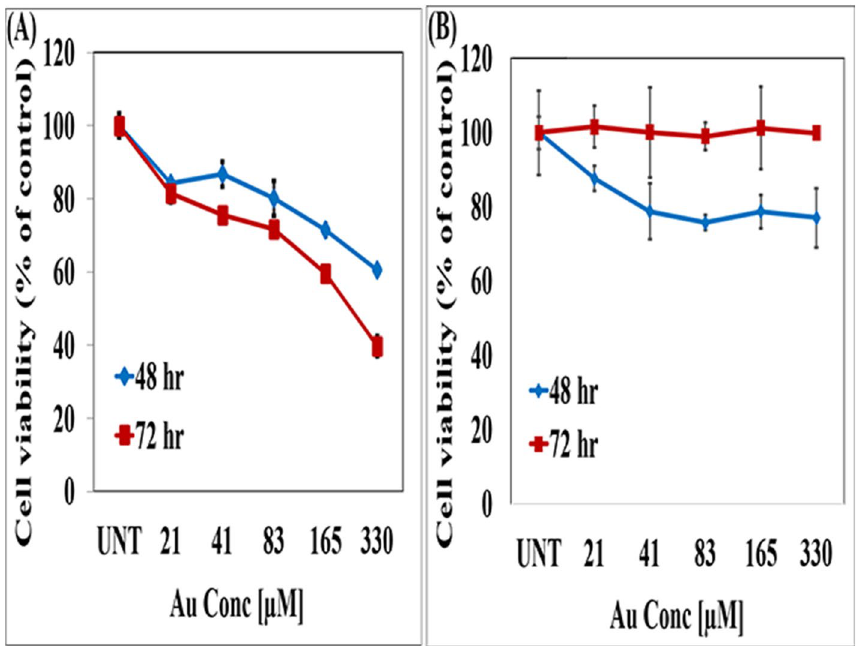
Figure 5. MGF-AuNPs inhibit the proliferation of PC-3 cells and not HAECs. ( A ) PC-3 cells were cultured in 96 well plates overnight for adherence and rest. The cells were treated with indicated doses of MGF-AuNPs and for 48 and 72 h. MTT assay was performed at the end of the treatment. ( B ) HAECs were cultured overnight in 96 well plates for rest and adherence. The cells were treated MGF-AuNPs for indicated times and doses. MTT assay was performed at the end of the